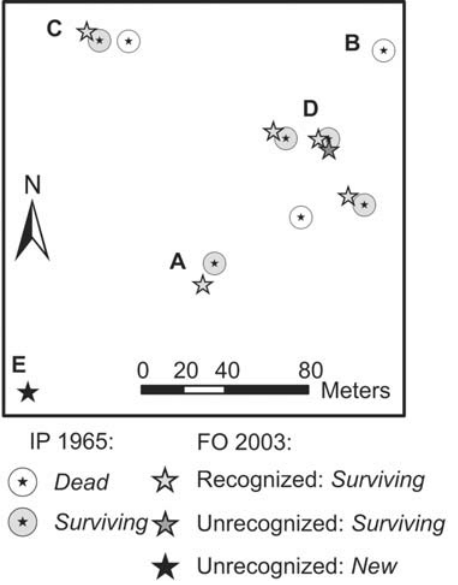
Figure 3. Change Categorization; an example from Wadi Gaetri. Distance is measured from each interpreted point (IP) to the nearest field observation (FO) with canopy area . 6 m 2 . A If an IP has only one FO closer than 20 m, the two points are considered as referring to the same tree and categorized as surviving . B If an IP is separated by more than 20 m from any FO it is considered unmatched and categorized as dead . C If two IPs have the same FO closer than 20 m, the pair with the shortest distance is considered as referring to the same tree and the IP categorized as ‘‘ surviving ’’. The second IP is categorized as dead if no other FO is closer than 20 m. Unmatched FOs are categorized as unrecognized and can be either D accounted for and merged with surviving or E not accounted for and merged with new (cf.